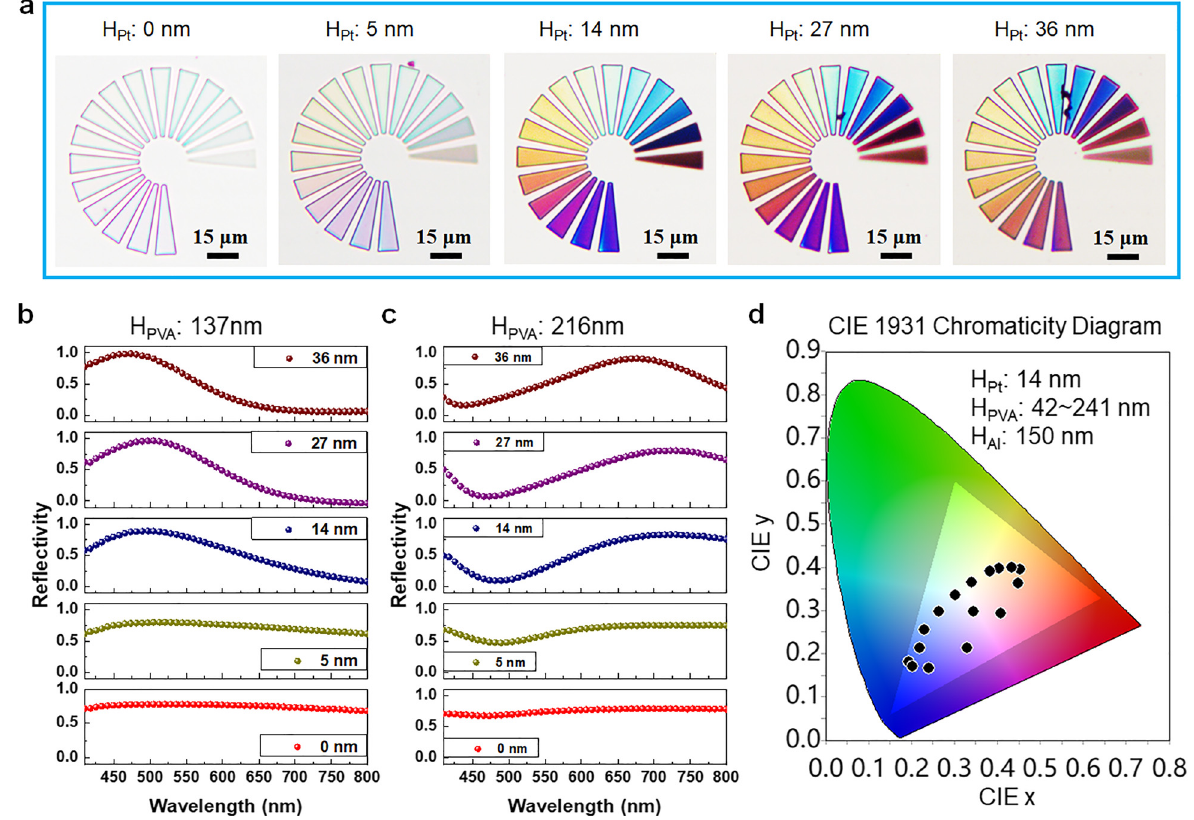
Figure2: (a)Photographofmulti-colorpalettescoatedwithH Pt of0,5,14,27,36nm,respectively.Re fl ectionspectraofPVAlayerswithH PVA of (b)137and(c)216nm,coatedwithH Pt of0,5,14,27,36nm,respectively.(d)CIE1931colorcoordinatevariationdiagrambasedonFabry – Perot cavities with varied H PVA between 107 and 234 nm, and H Pt of 14